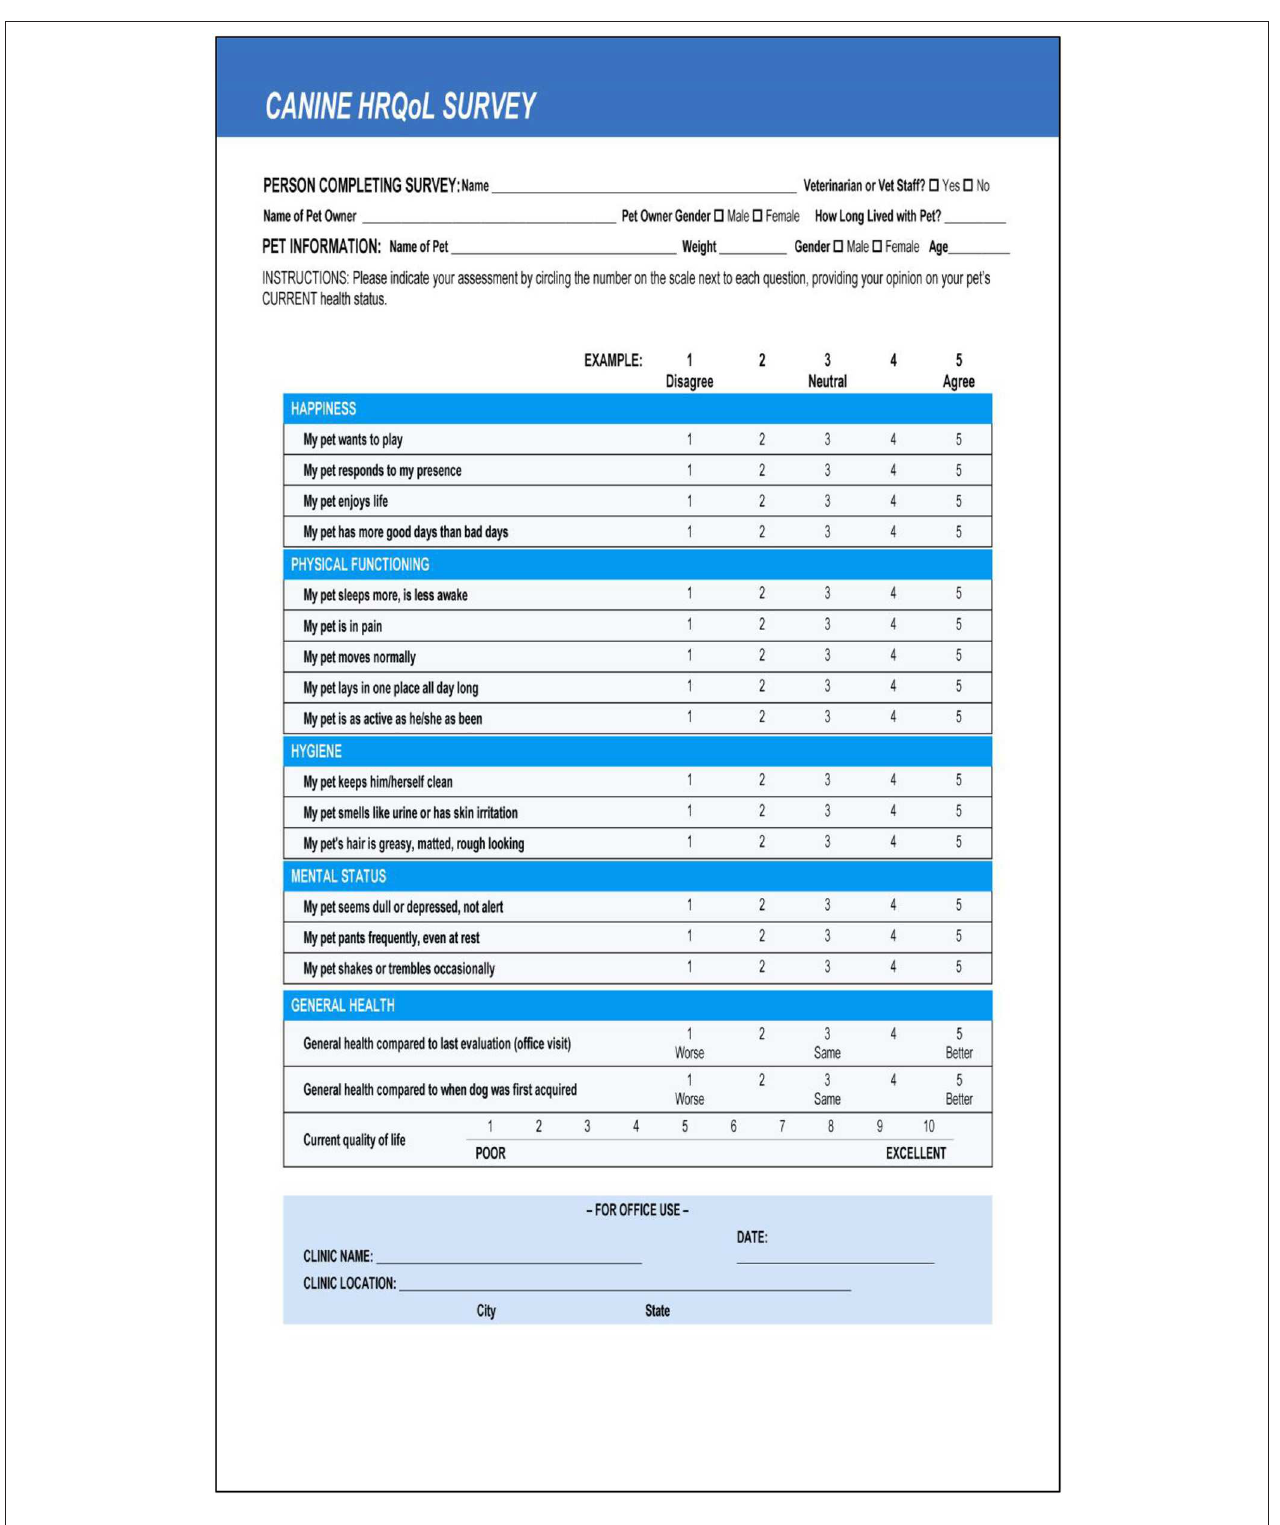
FIGURE 1 | The Healthy Dog QOL Survey.